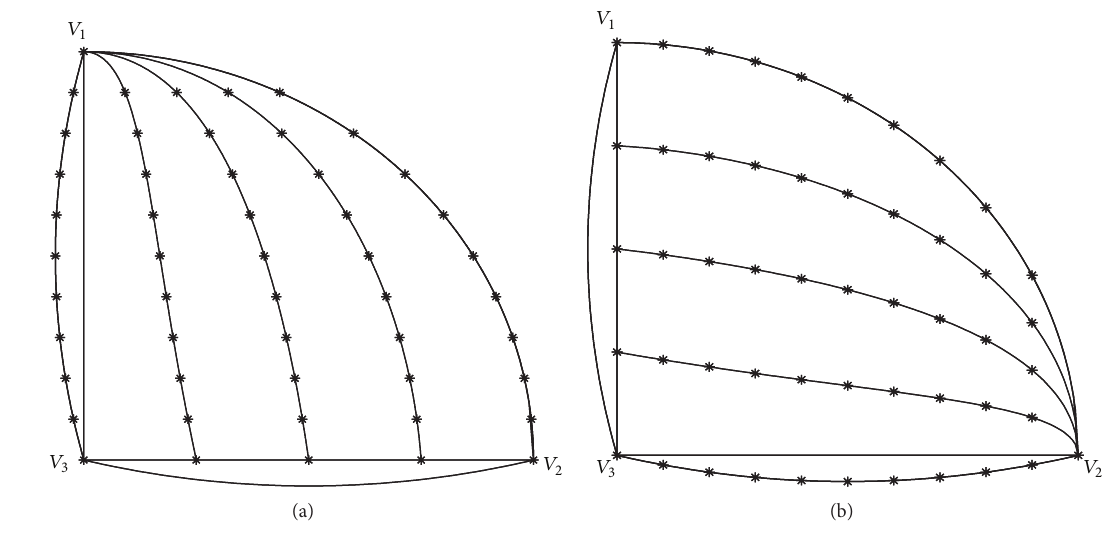
Figure 2: (a) Points of Δ 𝑥 𝑚 , for 𝑚 = 4 . (b) Points of Δ 𝑛 𝑦 , for 𝑛 = 4